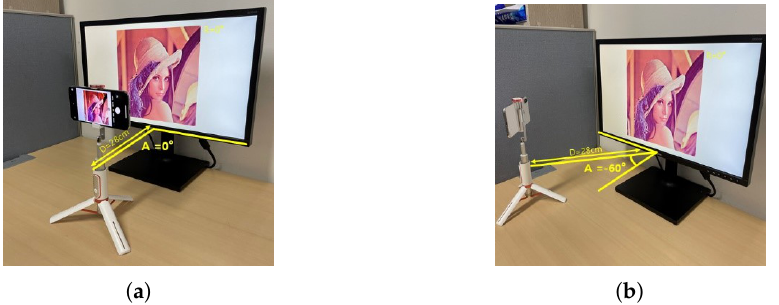
Figure 16. Experimental setup according to display-camera angle. ( a ) A = 0 ◦ . ( b ) A = − 60 ◦ .